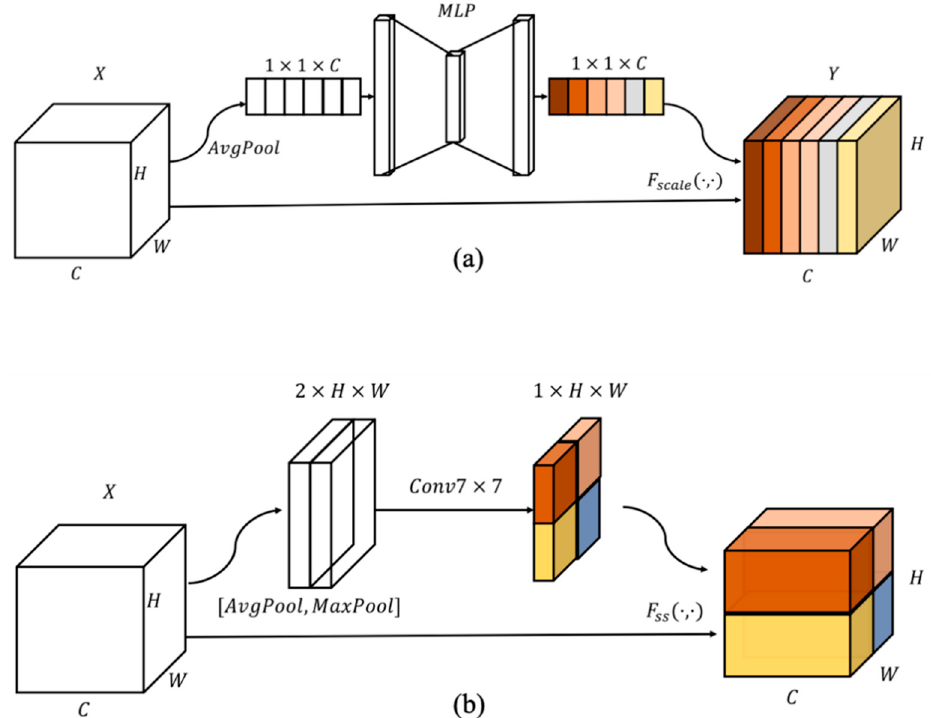
Figure 2. ( a ). A Squeeze-and-Excitation (SE) block. ( b ). A spatial sub-module of the convolution block attention module (CBAM). block attention module